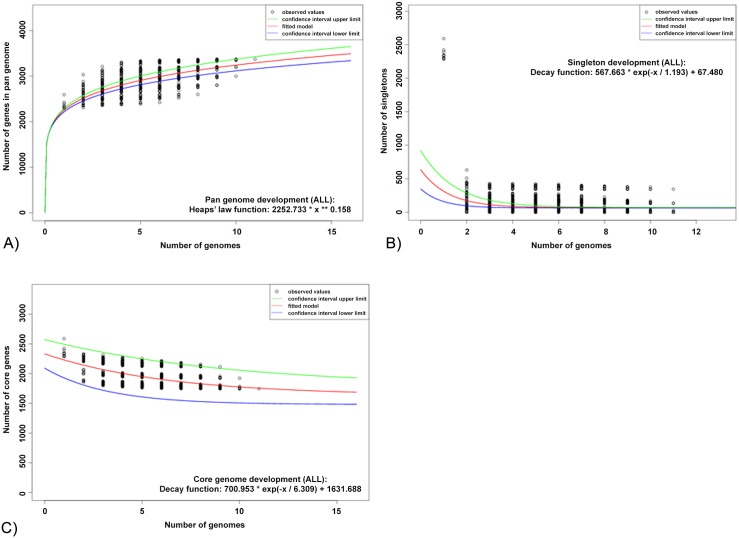
F. psychrophilum pan, core and accessory genome evolution according to the number of sequenced genomes.A) Total number of genes (pan-genome) for a given number of genomes sequentially added. The pan genome analysis is shown for increasing values for every F. psychrophilum genome sequenced based on a power law fit model. B) Number of shared genes (core genome) as a function of the number of genomes sequentially added. The exponential decay model based on the median value for the conserved core genes displays that the core genome had a minimum of 1743 genes in F. psychrophilum. C) Number of unique genes (accessory genome) for a given number of genomes sequentially added. Decreasing number of accessory genes per genome was observed with increased of genomes examined. The graphic shows the exponential decay model based on the median value for the accessory genes when increasing numbers of genes were analyzed. An average of 67 new genes could be detected in the F. psychrophilum pan genome for each new genome added. For all the plots the upper (green) and lower (blue) lines indicate the first (25th percentile of the data) and third (75th percentile) quartiles respectively. The central (red) line refers the sample median (50th percentile) of random input order of the F. psychrophilum genomes.